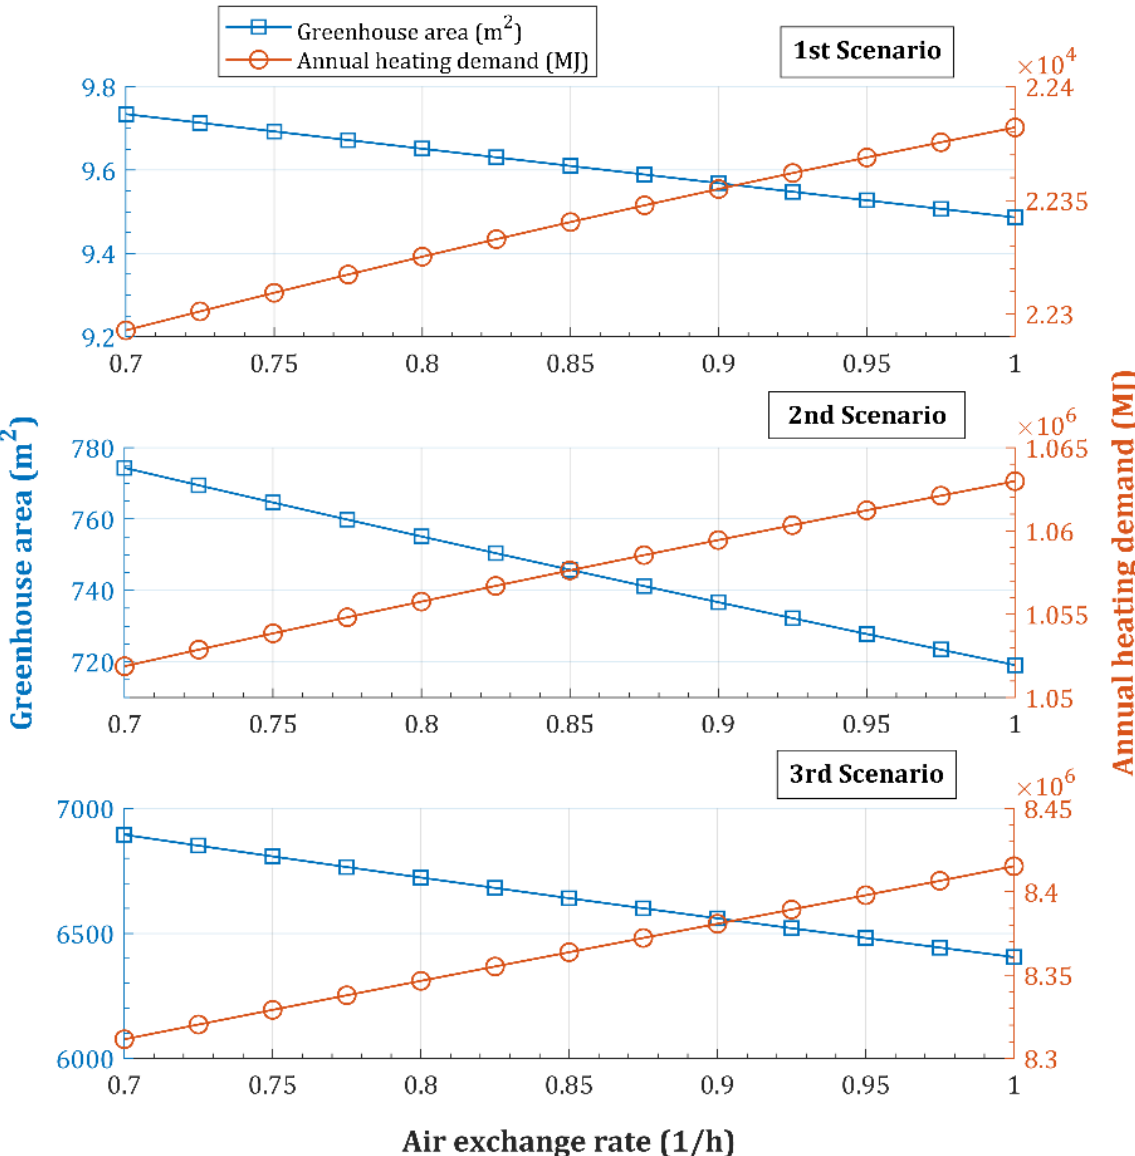
Figure 15. Variations of the greenhouse size and annual heating demand under the variation of the air exchange rate.